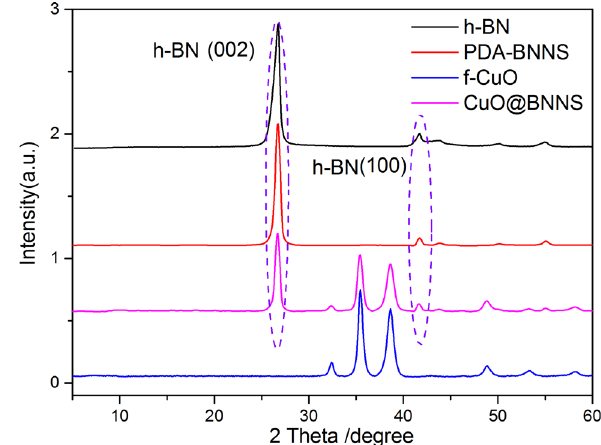
Fig.2 FT-IR spectra of CuO, f-CuO, PDA-BNNS and CuO@BNNS nanocomposite